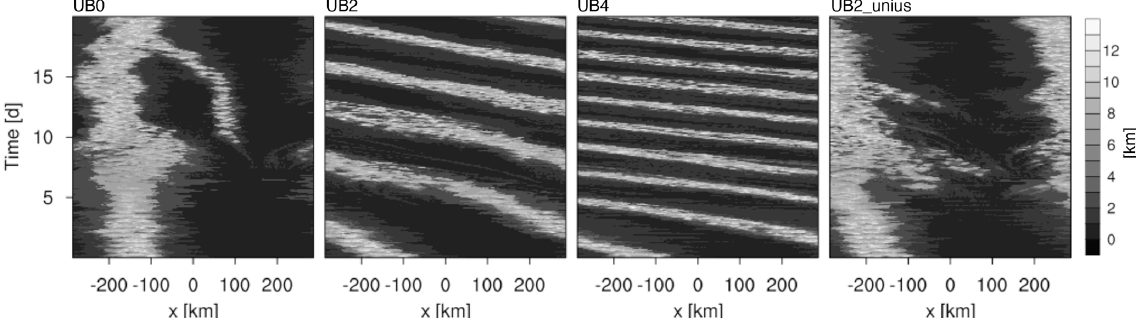
Figure 6. Hovmöller diagram of the cloud-top height averaged over the y axis for each experiment. This displays the cloud-top movement with respect to the model grid, thus u rel in Eq.